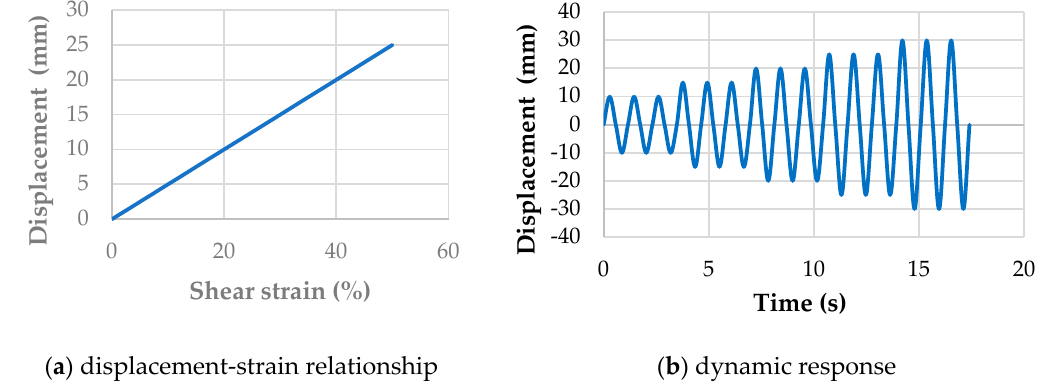
Figure 6. ( a ) applied horizontal displacement against shear strain ( b ) applied horizontal displacement against time history used for all the simulations of the model SP unit cell bridge bearing under both monotonic and cyclic loading, respectively.